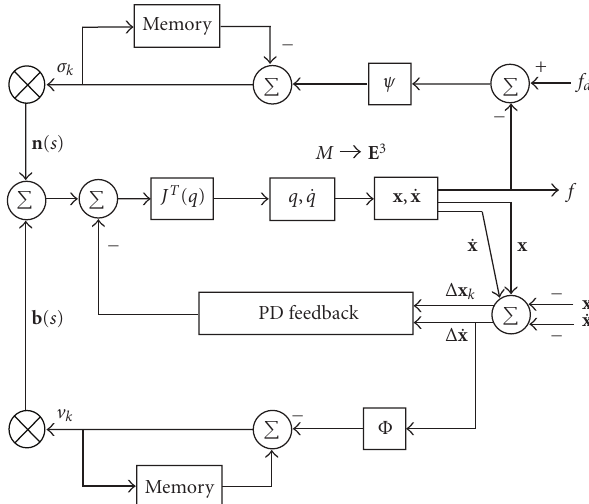
Figure 11: Iterative learning control scheme for robotic handwrit-